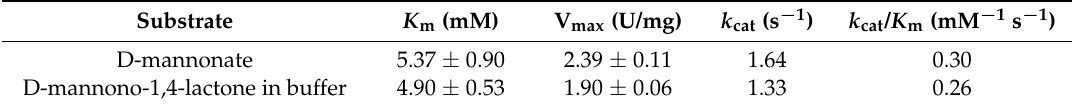
Table 1. TaManD kinetic data with D-mannonate (prepared by hydrolysis with NaOH) and with